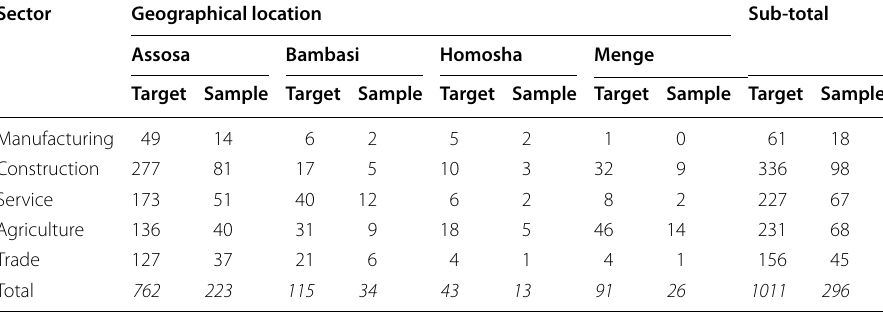
Table 2 Proportional distribution of representatives Sector Geographical